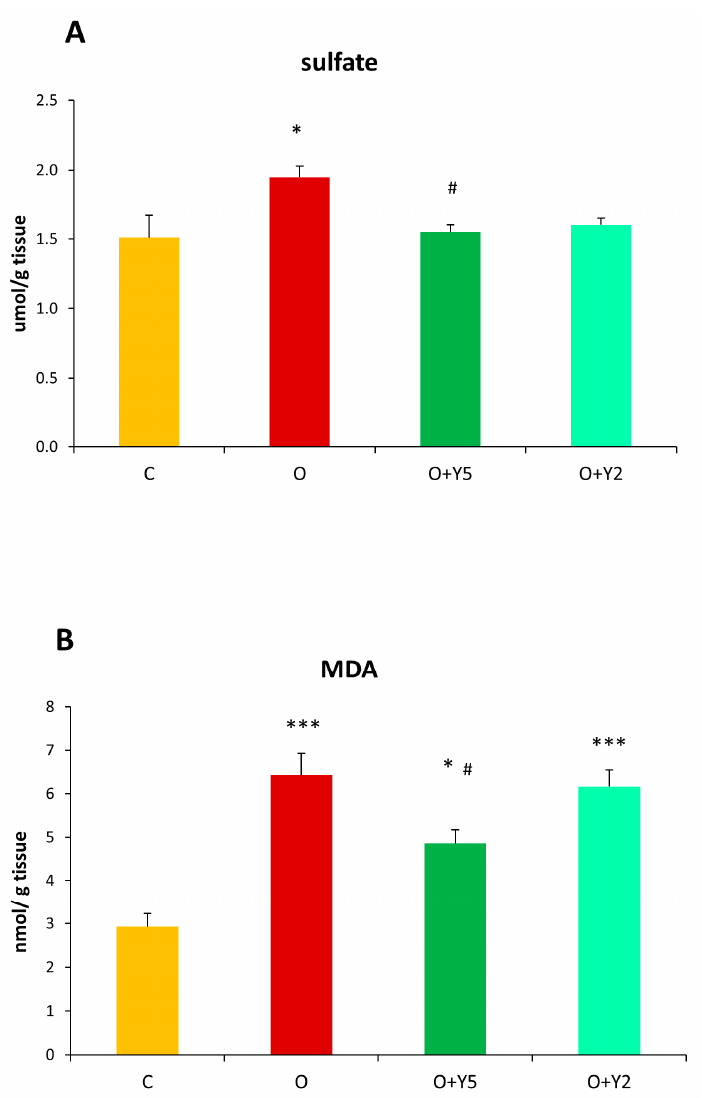
Figure 3. Concentration of sulfates ( A ) and the level of malondialdehyde (MDA) as a measure of lipid peroxidation ( B ) in the livers of rats. C—control rats fed a standard diet; O—rats fed with HFD; O + Y5—rats fed with HFD and then treated intraperitoneally (i.p.) with yohimbine at a dose of 5 mg/kg/day for 30 days; O + Y2—rats fed with HFD and then treated intraperitoneally (i.p.) with yohimbine at a dose of 2 mg/kg/day. Data are presented as the mean ± SEM, n = 6 per group. Statistical analysis was performed using a one-way ANOVA; symbols indicate significance of differences according to the Tukey post hoc test, * p < 0.05, *** p < 0.001 vs. group C; # p < 0.05 vs. group O.